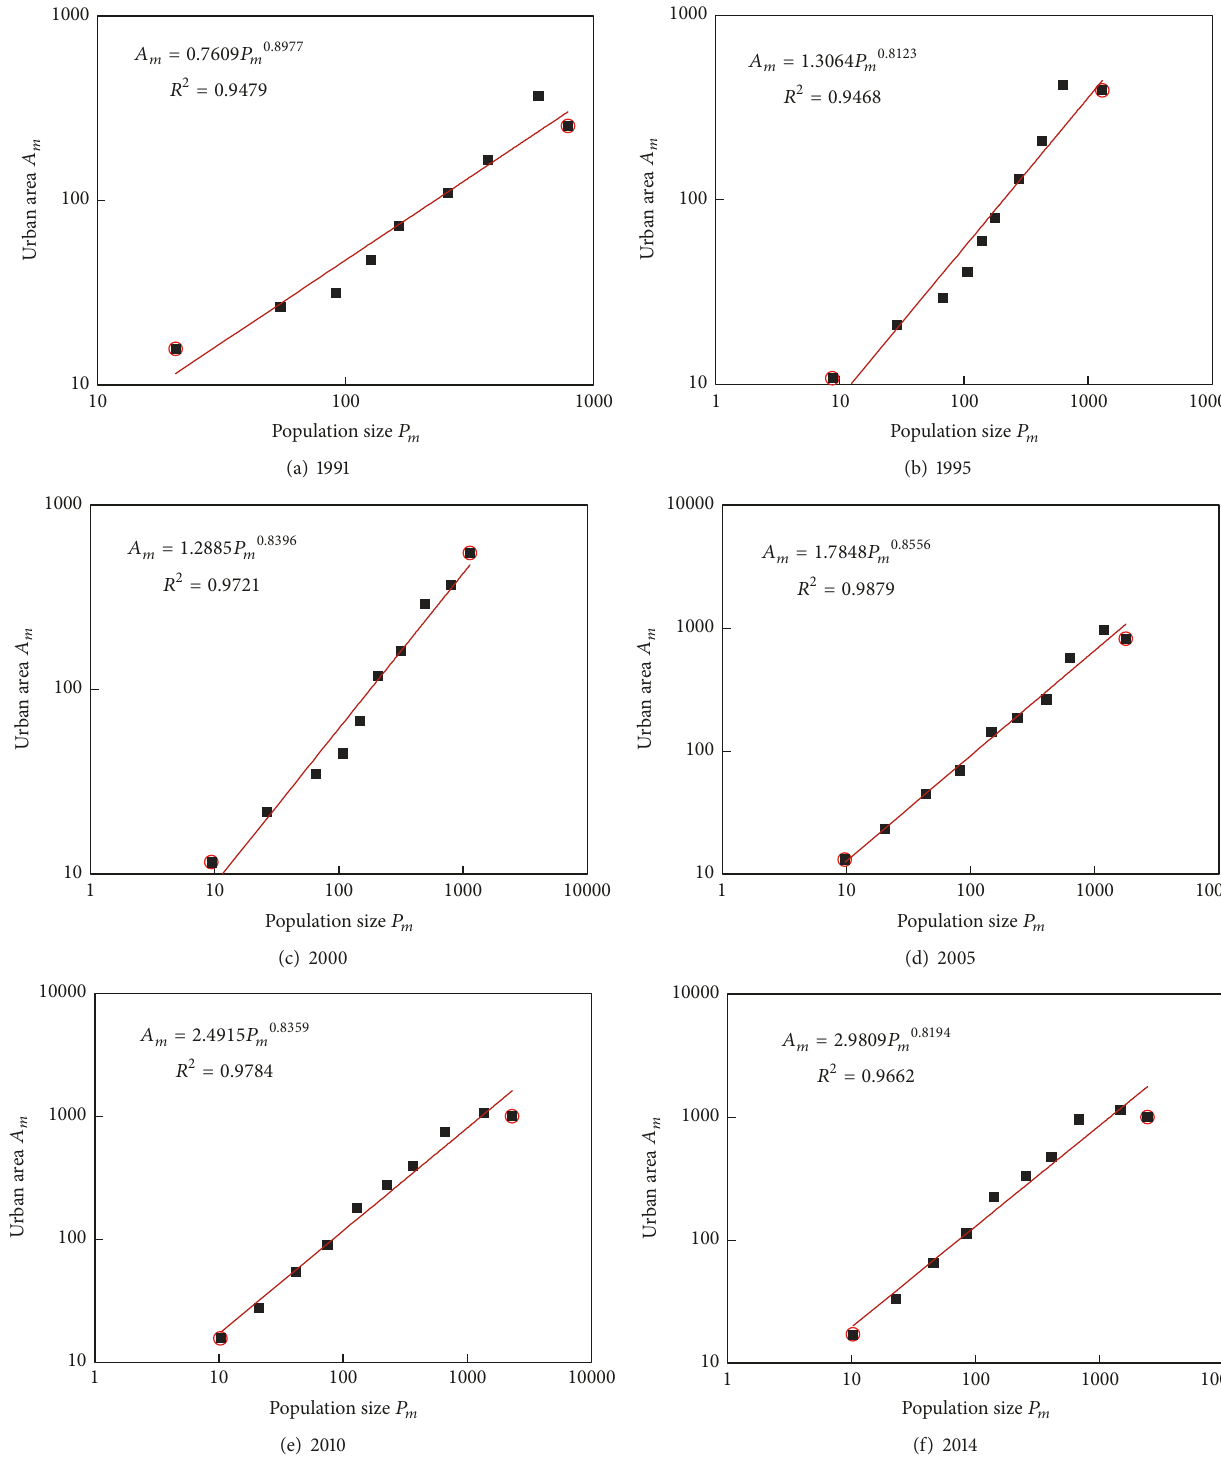
Figure 6: The hierarchical allometric scaling relationships between population size and area of built district of Chinese cities (examples) . [ Note . The small circles represent the largest city at the top class and the bottom cities at the lame-duck classes. The trend lines are based on all the data points rather than those within the scaling